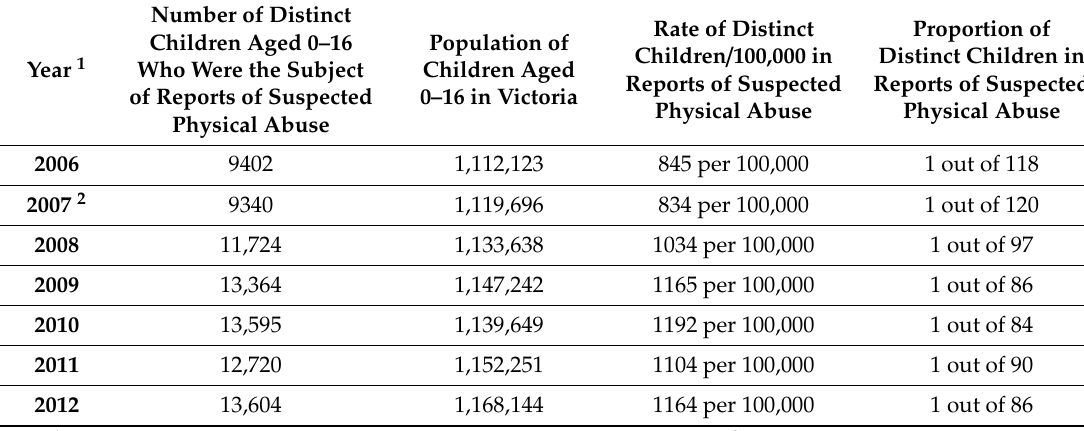
Table 4. Number and rate of children in reports of child physical abuse: Victoria